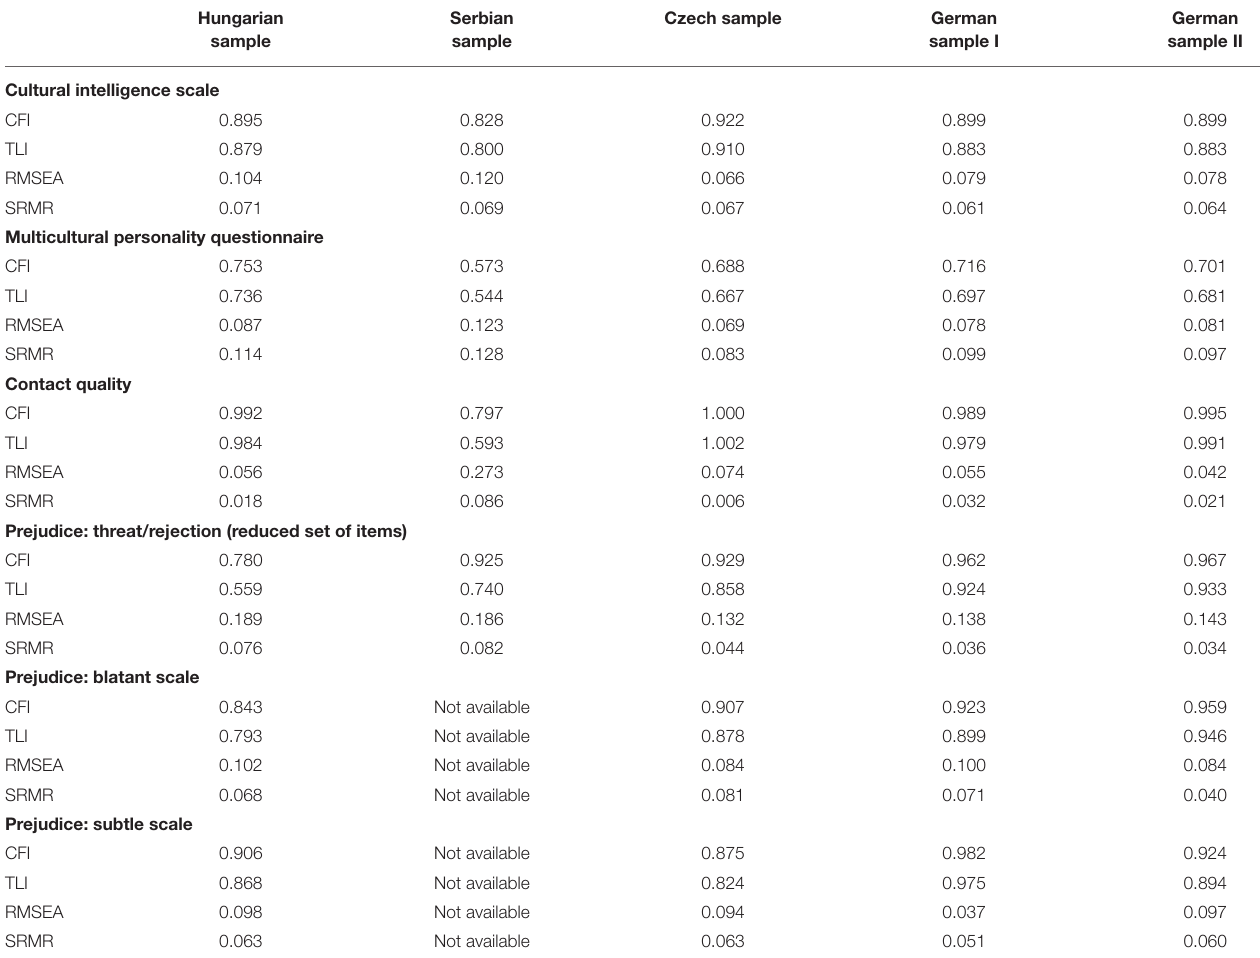
TABLE 2 | Fit indices from the confirmatory factor analyses for each scale and sample. Hungarian sample